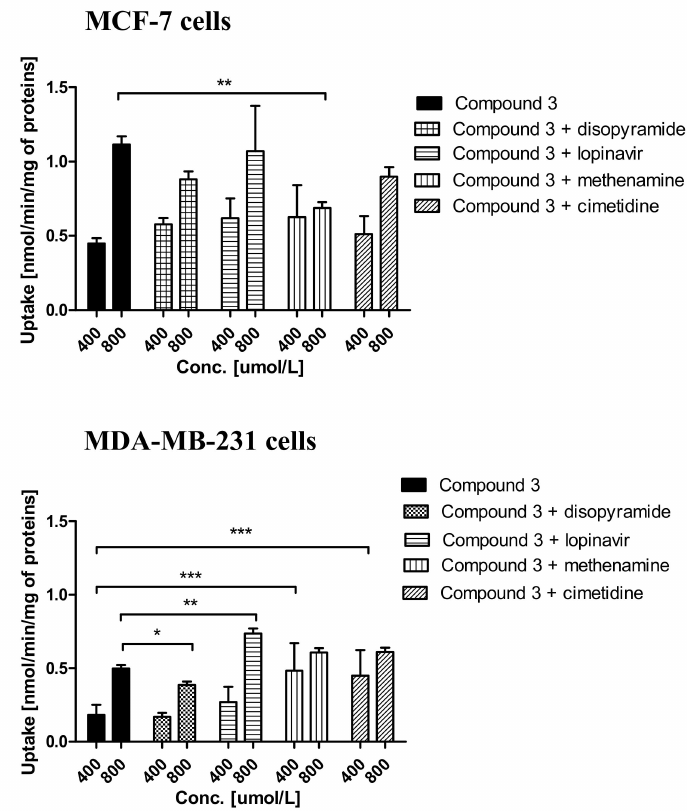
Figure 4. The uptake mechanism of compounds 1 – 3 (400 and 800 µ mol / L) into MCF-7 cells and MDA-MB-231 cells. The uptake was determined in the presence of OCT and MATE inhibitors, disopyramide, lopinavir, methenamine or cimetidine (400 and 800 µ mol / L) for 10 minutes at 37 ◦ C. One-way ANOVA analysis was performed to compare the uptake of pure compounds ( 1 – 3 at 400 and 800 µ mol / L) with their uptake in the presence of transporter inhibitors. The significant di ff erences between the uptake of pure compounds 1 – 3 (black bars) and their respective mixtures with inhibitors (disopyramide, lopinavir, methenamine or cimetidine) are marked with black lines and are denoted with asterisk. * p < 0.05, ** p < 0.01 and *** p < 0.001. In MCF-7 cells, the uptake of compound 1 at 400 µ mol / L was significantly decreased in the presence of cimetidine, while at 800 µ mol / L, the significant di ff erences were reported in the presence of disopyramide, lopinavir and cimetidine. In MDA-MB-231 cells, the uptake of compound 1 at 800 µ mol / L was significantly increased in the presence of disopyramide and lopinavir. The significant di ff erences in the uptake of compound 2 were reported in the presence of disopyramide, lopinavir and cimetidine in MCF-7 cells, while in MDA-MB-231 cells, no significant changes in the uptake of 2 in the presence of all inhibitors were reported. In MCF-7 cells, the uptake of compound 3 at 800 µ mol / L was significantly decreased in the presence of methenamine in comparison to compound 3 alone. In MDA-MB-231 cells, the uptake of compound 3 was significantly di ff erent in the presence of all inhibitors, depending on the compound